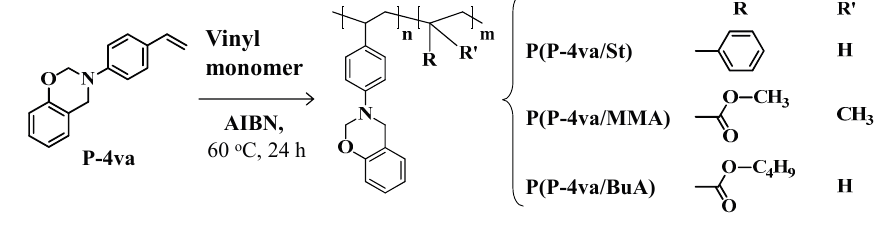
Scheme 3. Radical copolymerization of P-4va with various vinyl